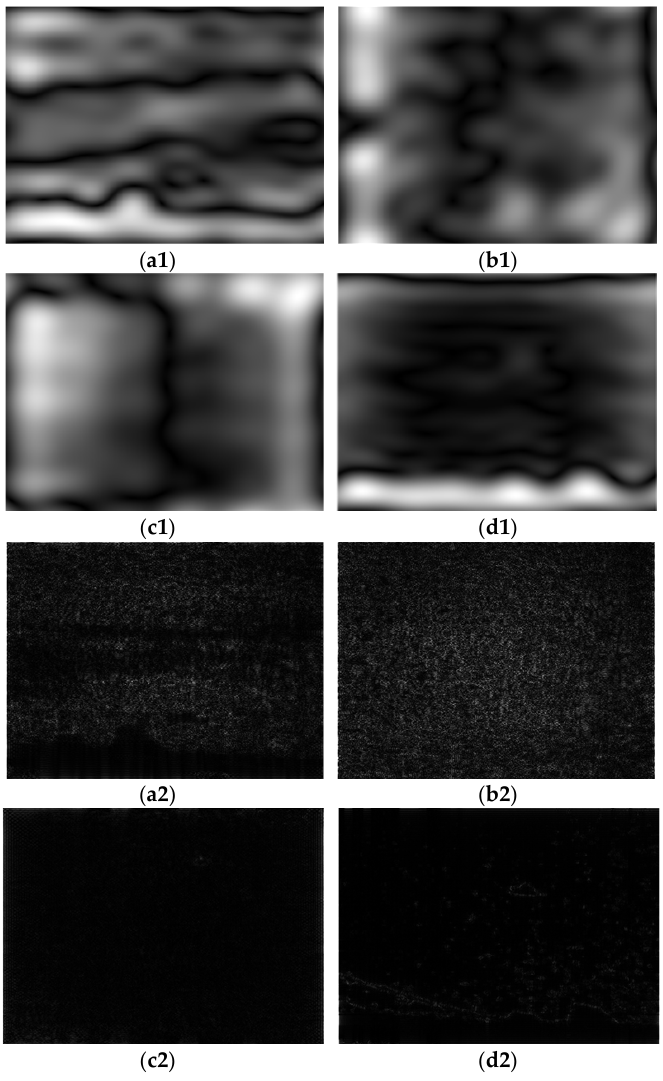
Figure 5. Frequency domain characteristic analysis. ( a1 – d1 ) High frequency information. ( a2 – d2 ) Low frequency information.